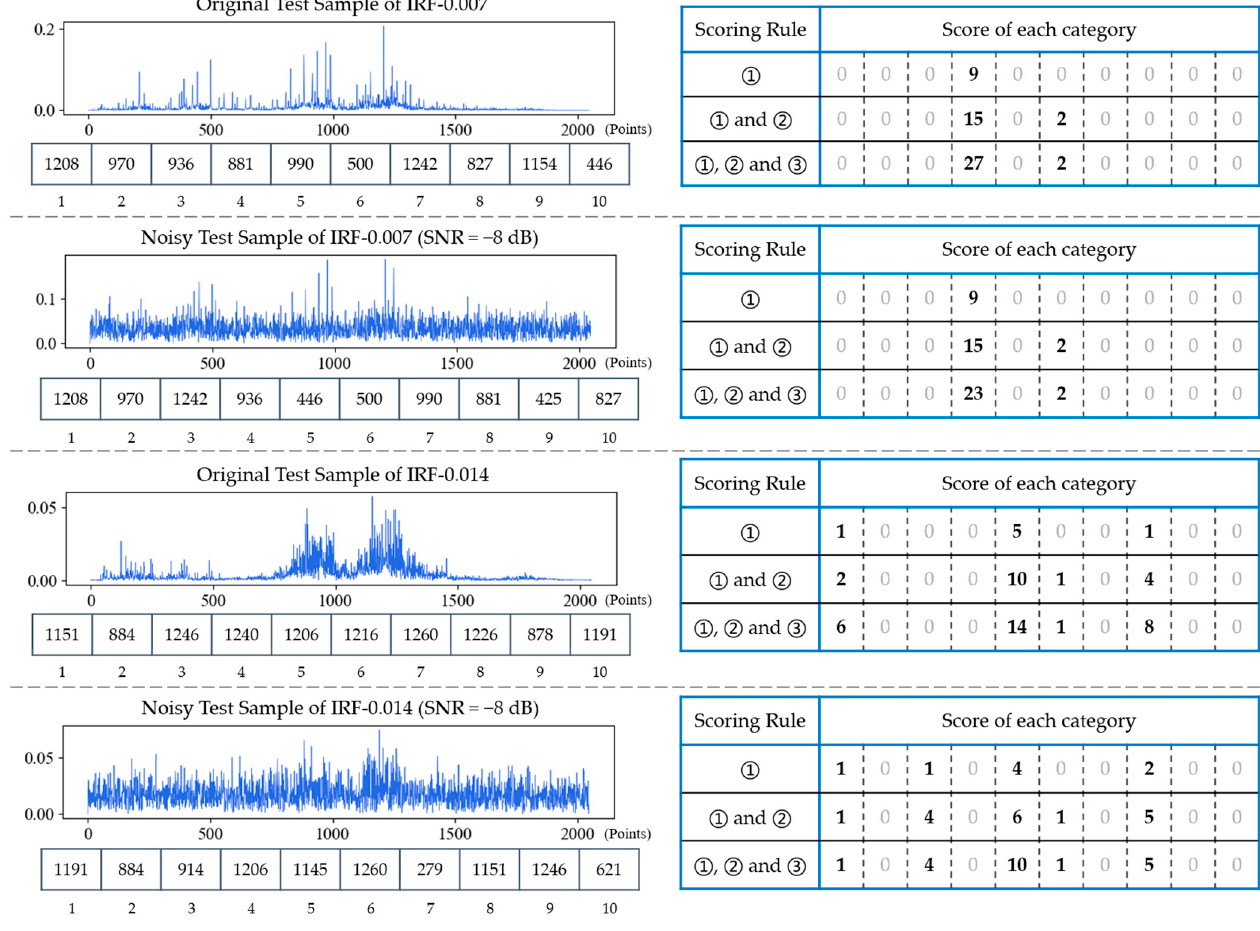
Figure 10. The frequency spectrums with their 10 feature frequencies of four test samples and their corresponding scoreboards obtained by different scoring rules. Table 3. Diagnosis accuracy of FDFM by different scoring rules under different